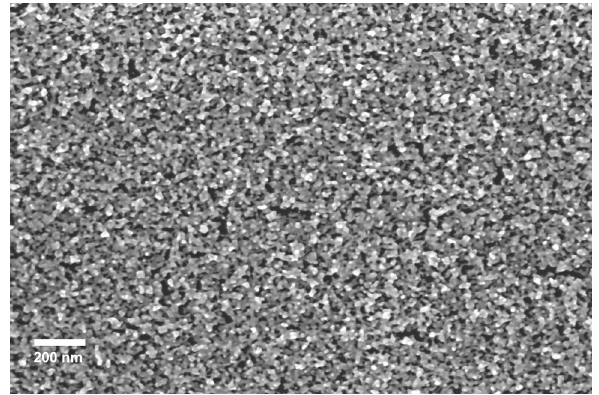
Figure 8. Scanning electron microscopy (SEM) micrograph of a cluster-assembled Au film deposited on Si